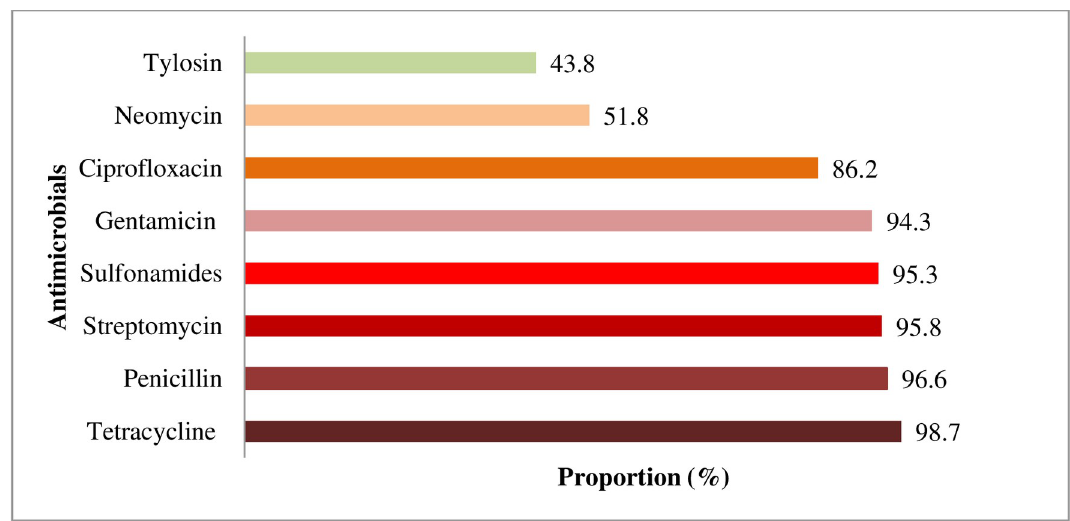
Fig 2. Antimicrobials frequently used by Fulani pastoralists on lactating cows in North-central Nigeria.